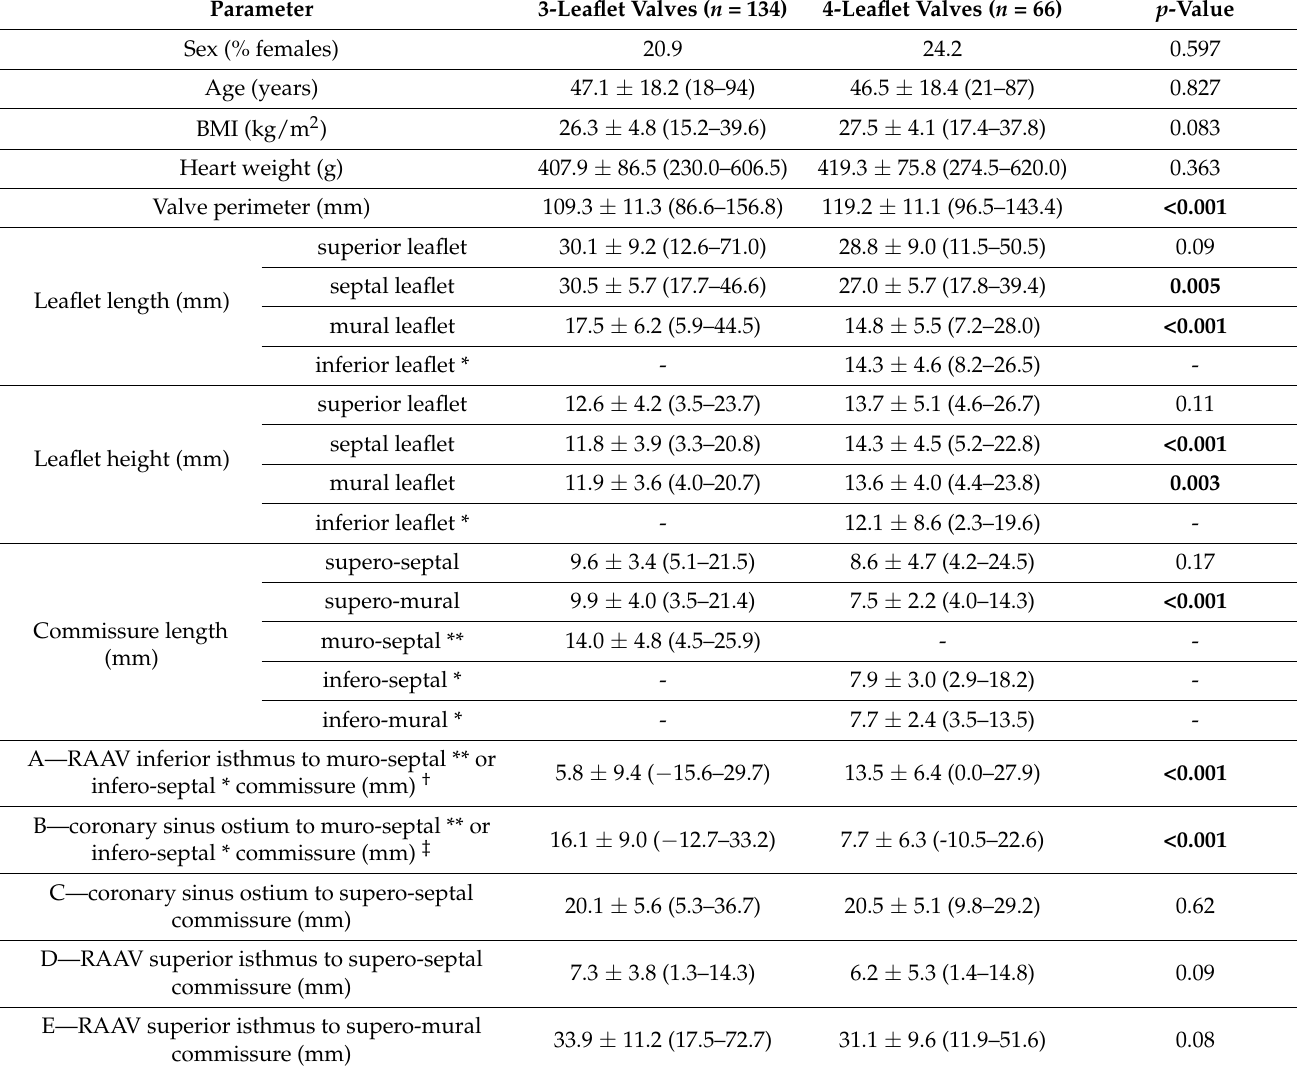
Table 1. Morphometric observations of structure and position of right atrioventricular valve in 3-leaflet and 4-leaflet configurations (mean ± SD with